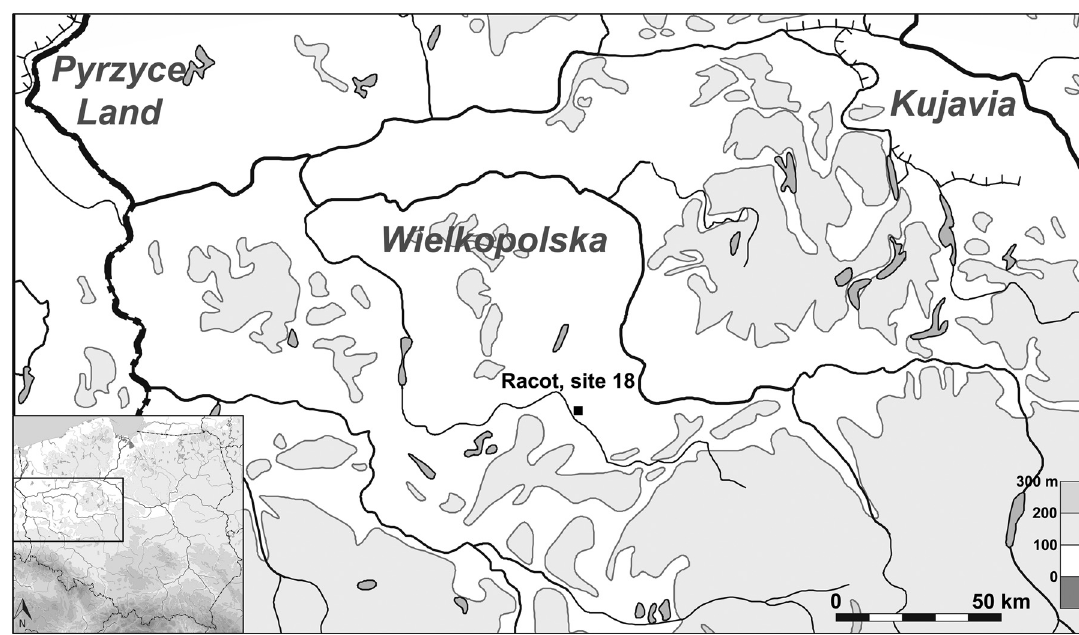
Figure 1: Location of Racot, site 18 in the Polish